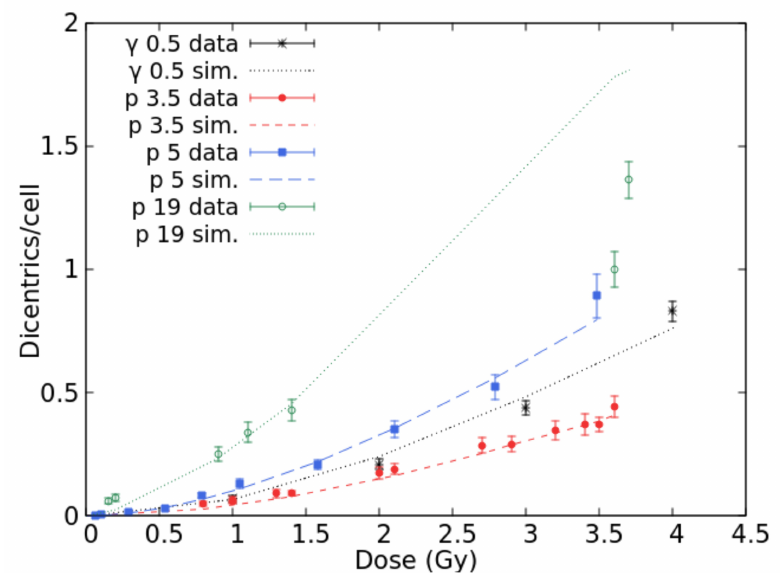
Figure 1. Mean number of dicentrics per cell versus dose for gamma-rays and protons (3.5, 5.0, and 19.0 keV/ µ m). The points with error bars are experimental data, the lines are simulation outcomes.